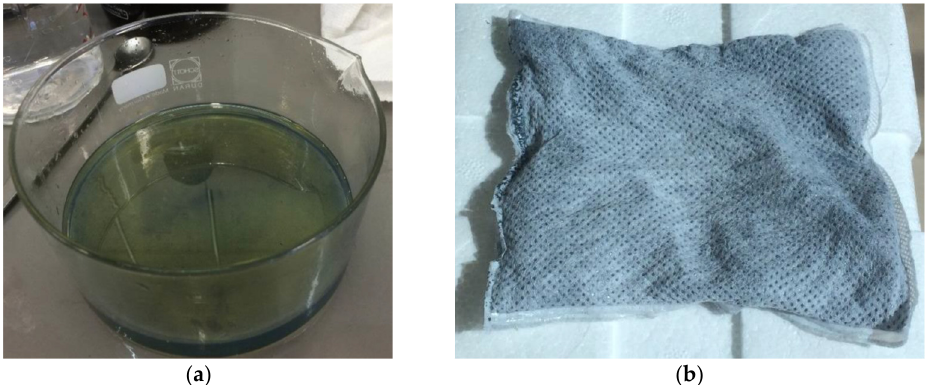
Figure 8. ( a ) Water appearance after test n.2 with Grafysorber ® G+ and diesel; ( b ) Pillow containing Grafysorber ® G+ after 6 cycles of adsorption/squeezing.